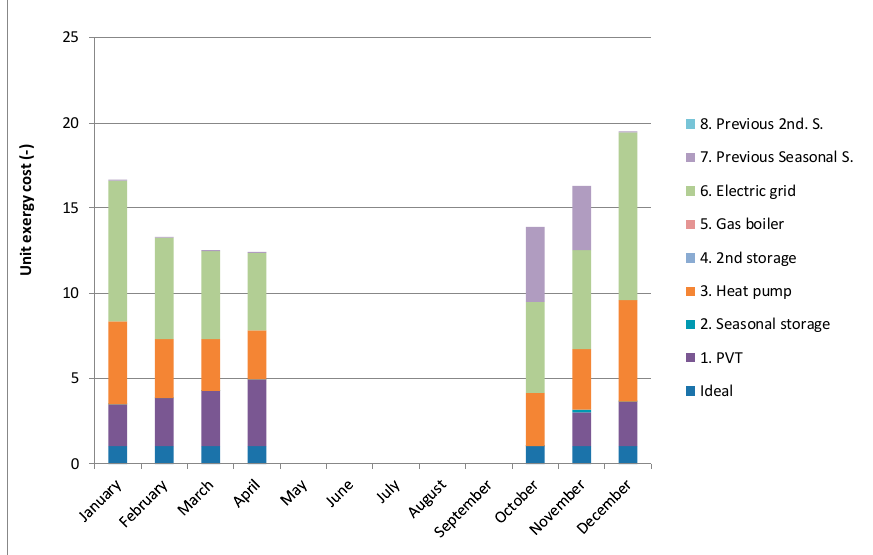
Figure 20. Seasonal storage: Cost formation by source.